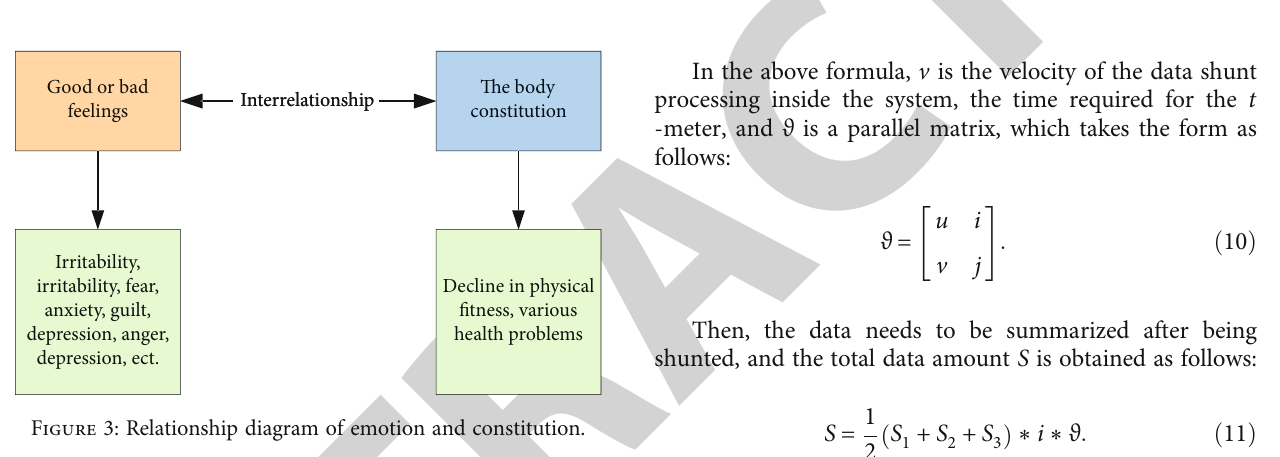
Figure 2: Particle swarm optimization process (PSO).